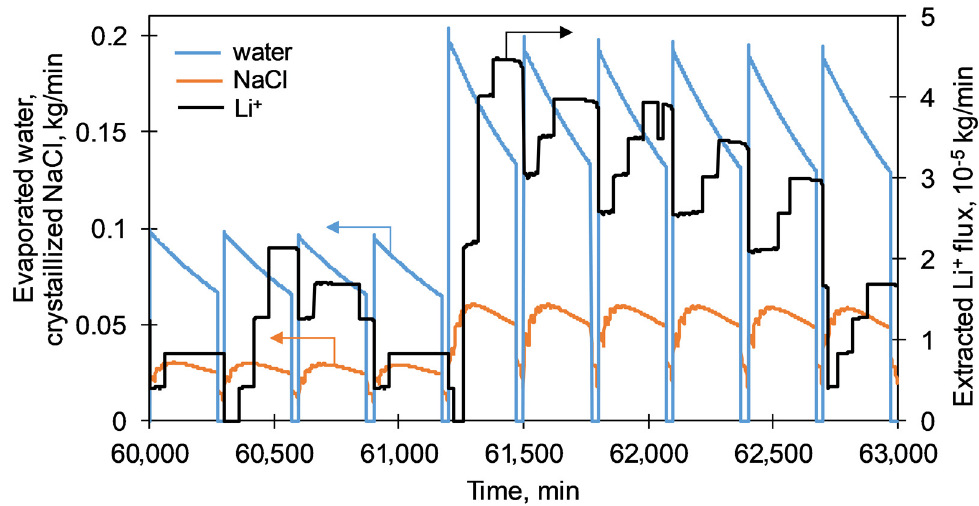
Figure 7. Change in time of amount of evaporated water, precipitated NaCl and recovered Li + . Simulation conditions: T f = 60 ◦ C, Rt = 4 h, RR = 99%, MPT = 50%, S = 2.5 m 2 , CF = 20, ER(Li + ) =